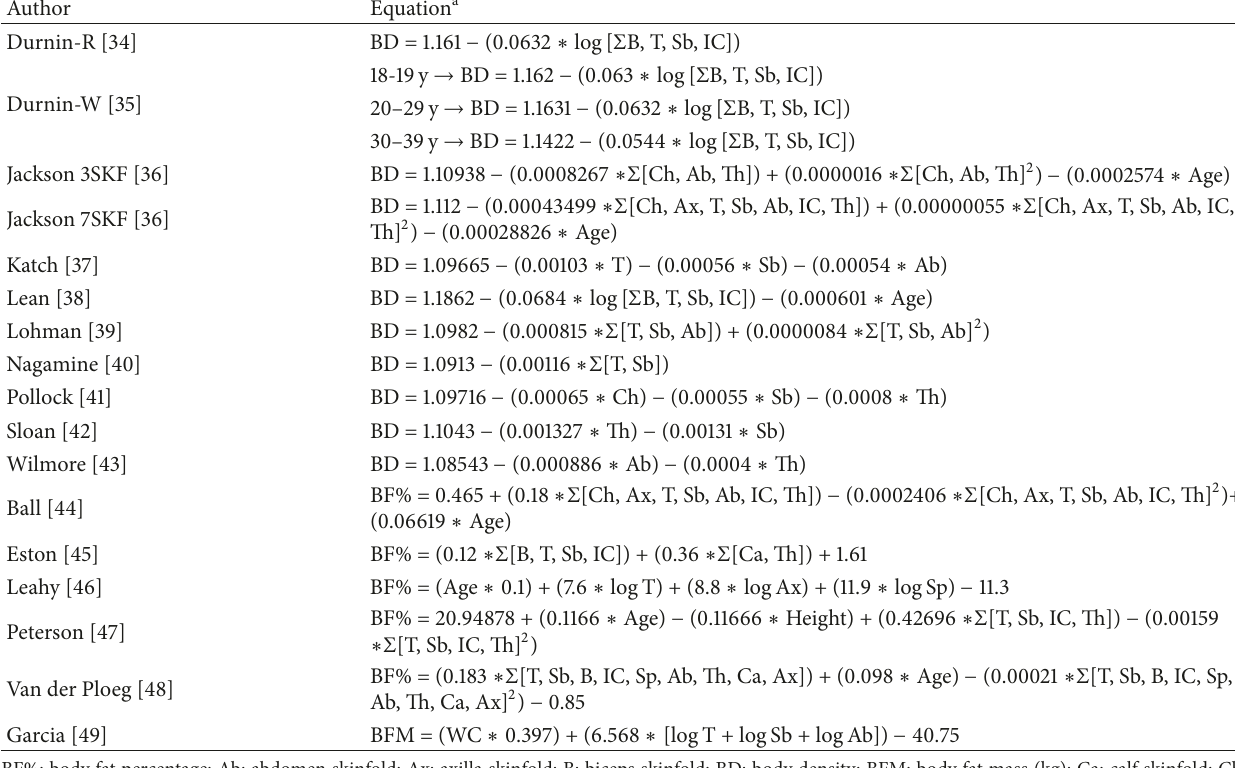
Table 2: Analyzed anthropometric equations (developed in nonathletic populations).